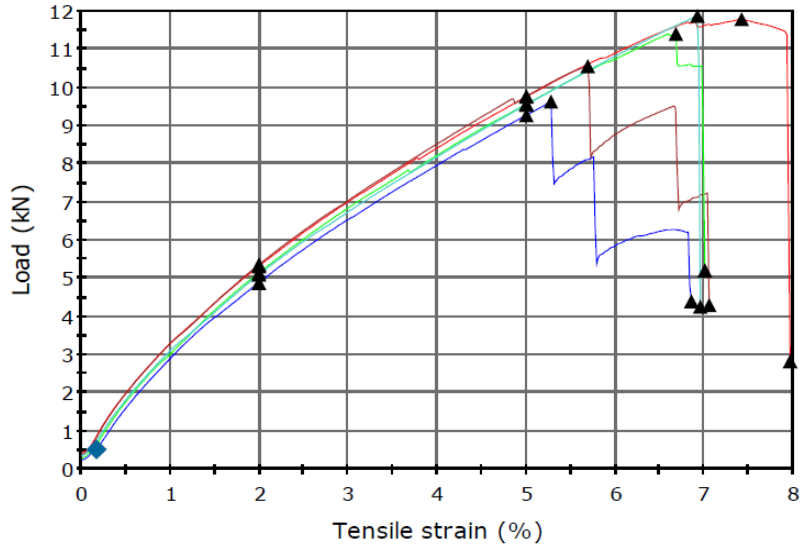
Figure 6. Tensile strength of an aged geogrid sample.